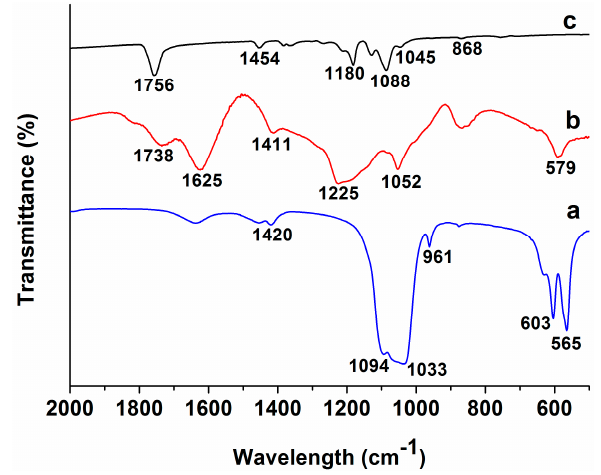
Figure 6. FTIR spectra of ( a ) nHA, ( b ) GO and ( c ) pure PLA specimens.